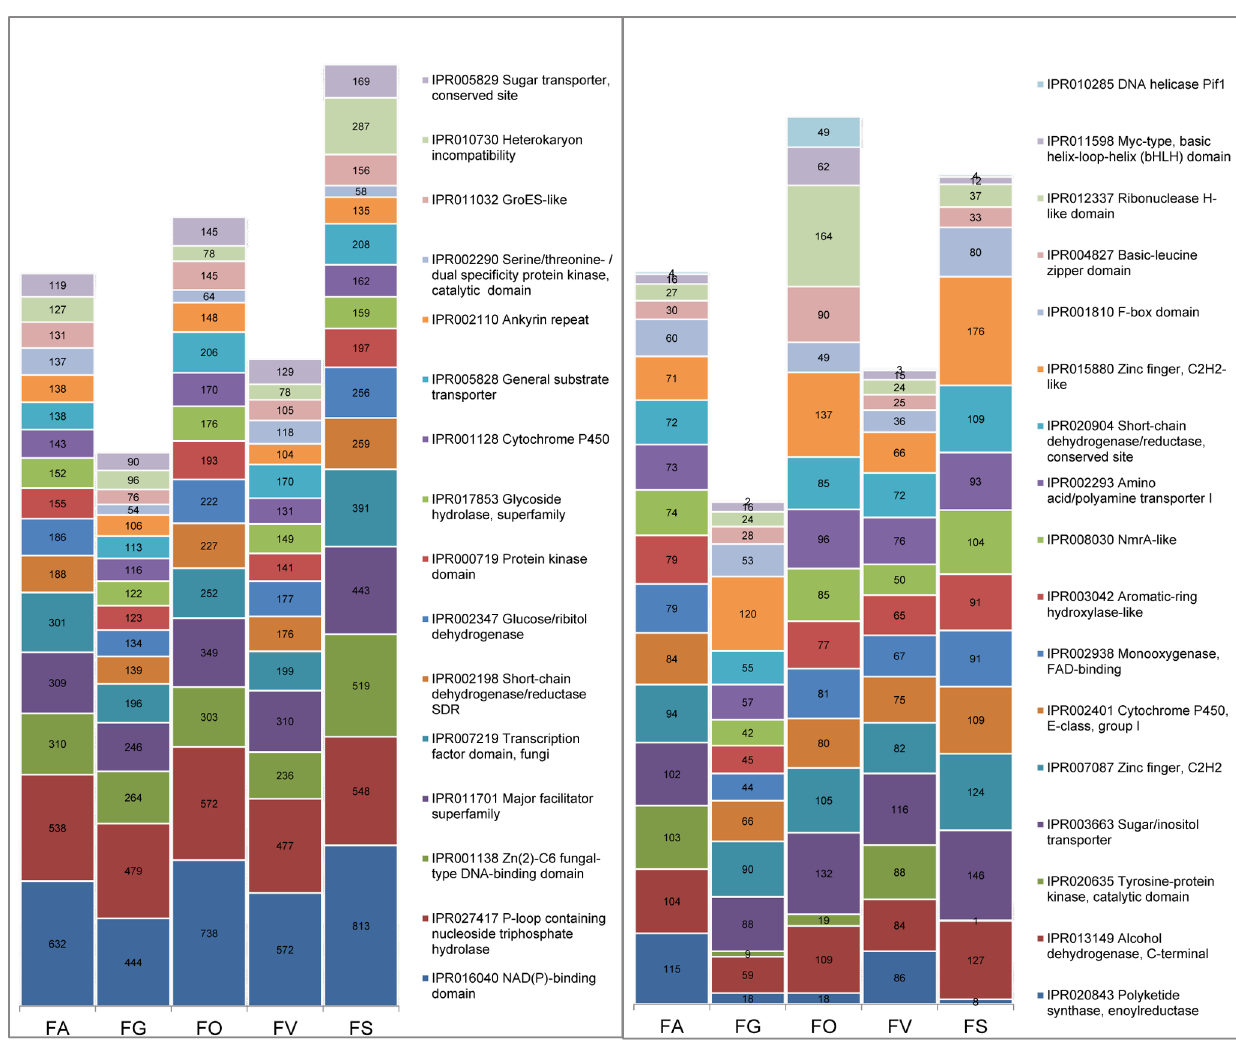
Figure 4. Functional analysis of Fa05001 and other sequenced Fusaria based on InterPro visualizing similarities and differences between the fungi. Categories with most differences between Fa05001 and others are presented with the number of proteins in each category. All details are listed in File S4. FA = F. avenaceum Fa05001, FG = F. graminearum PH-1, FO = F. oxysporum f. sp. lycopersici 4287, FV = F. verticillioides, FS = F. solani.